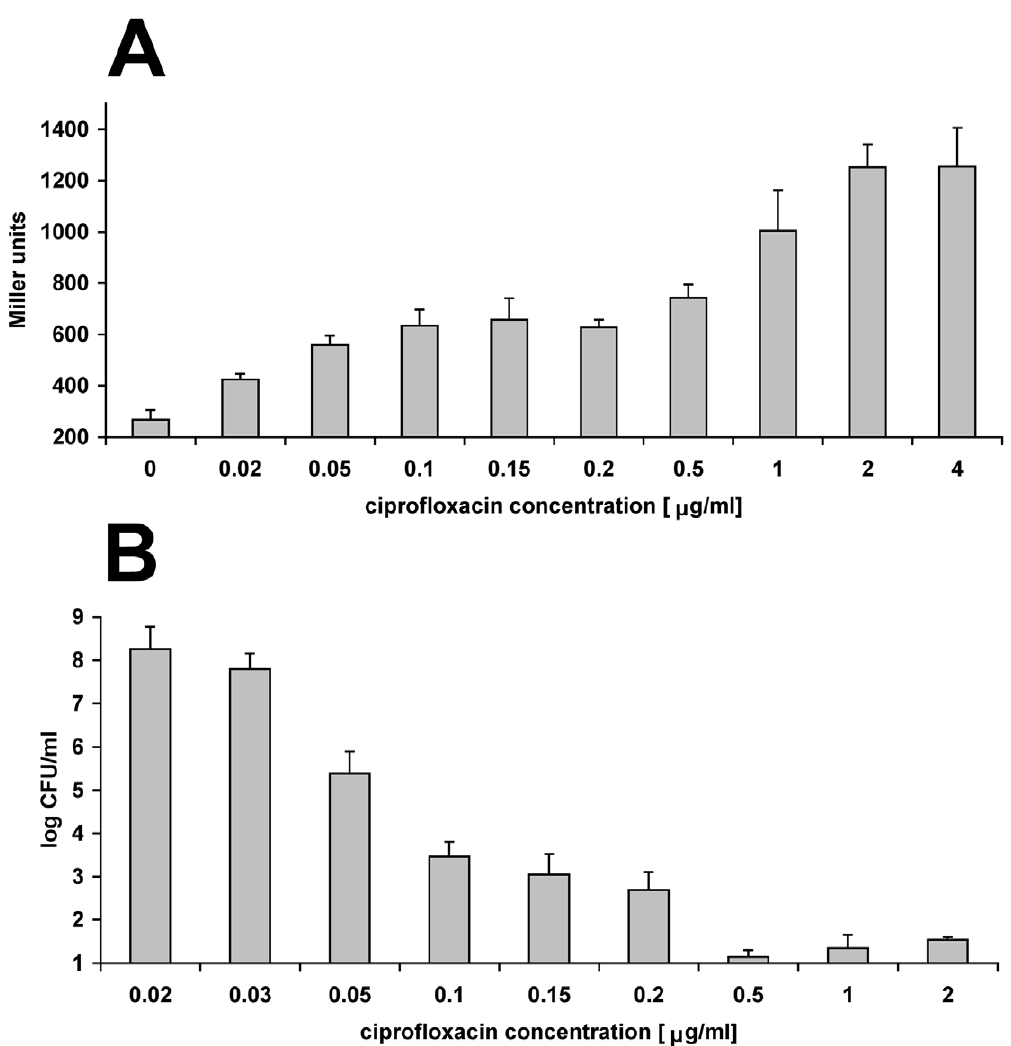
Figure 2. SOS induction and persister level during ciprofloxacin challenge in exponential growth phase. Graphs are averages of at least 3 independent experiments and error bars represent standard error. (A) Induction of the SOS-inducible recA gene expression measured by assaying the b -galactosidase activity after 15 min of ciprofloxacin challenge. (B) Persister levels after 6 hours of ciprofloxacin challenge.